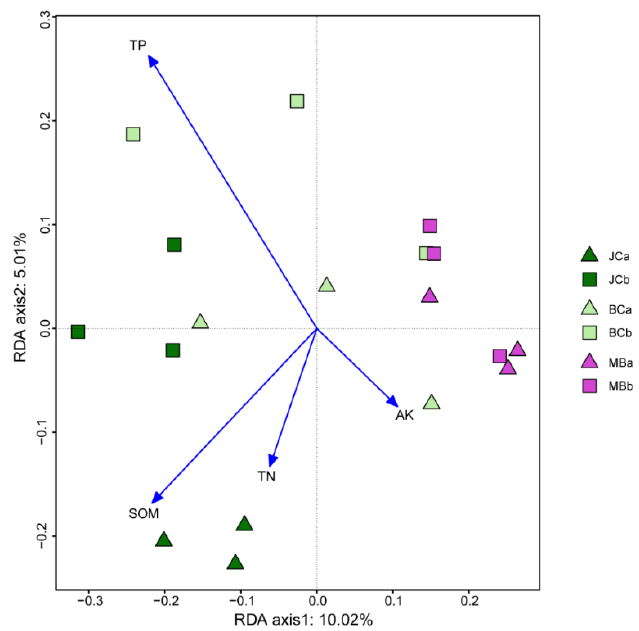
Figure 4. Redundancy analysis (RDA) of the AMF community (represented by OTUs). Note: JCa and JCb are 0 − 10 cm soil layer and 10 − 20 cm soil layer of Japanese cedar, respectively; BCa and BCb are 0 − 10 cm soil layer and 10 − 20 cm soil layer of bamboo–cedar mixed, respectively; MBa and MBb are 0 − 10 cm soil layer and 10 − 20 cm soil layer of moso bamboo, respectively. SOM, TN, TP, AP, and AK indicate soil organic matter, total nitrogen total phosphorus, available phosphorus, and available potassium, respectively.